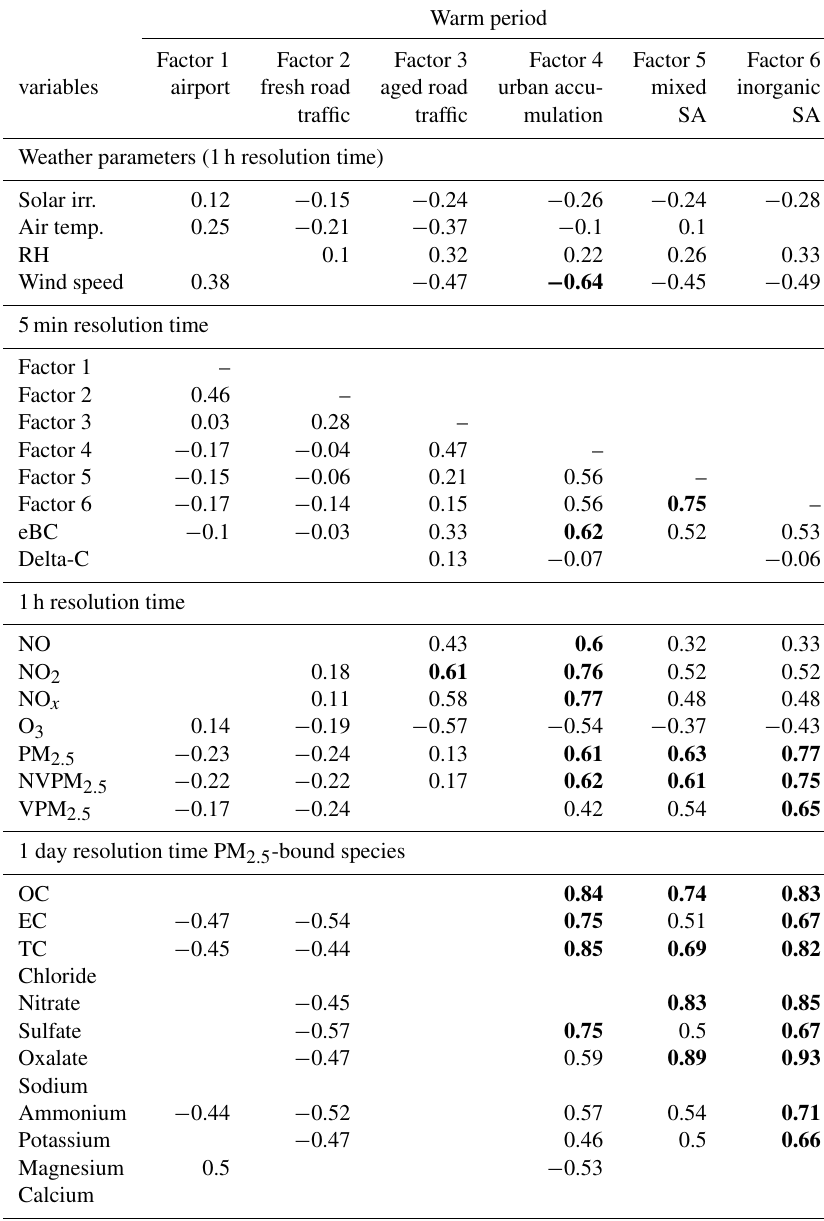
Table 2. Results of Pearson’s correlation analysis among extracted factor contributions and other measured variables recorded at different time resolutions. Only correlations significant at p < 0 . 05 are reported; strong correlations ( ρ > | 0 . 6 | ) are highlighted in bold. TC: total carbon (OC +